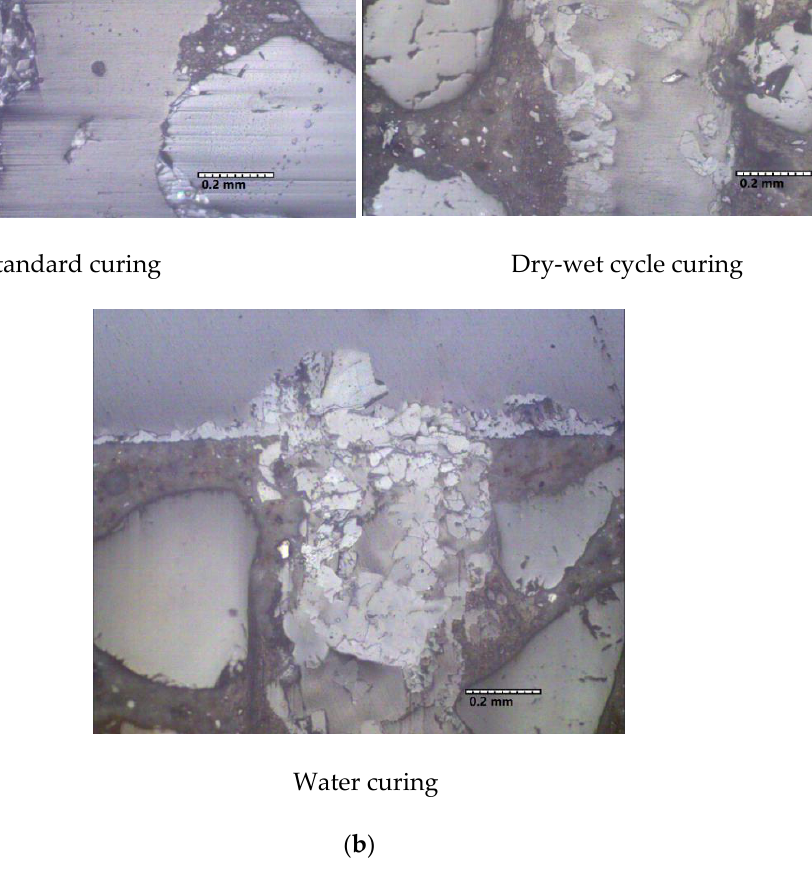
Figure 8. Healing products in shallow cracks under different exposure environments: ( a ) control; ( b ) with bacteria.